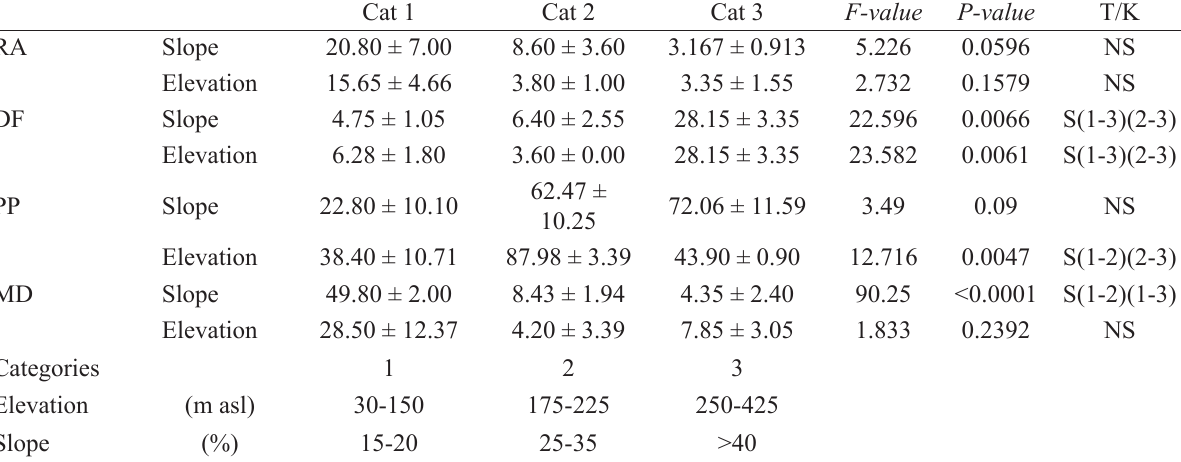
Table 3. ANOVA analysis of patch surface (percentage of DF surface at plot, plots mean ± SE) in various vegetation units taking plot’s elevation (m asl) and slope (%) as factors: Rural areas (RA), Meadows (MD), Degraded Forest (DF) and Conifer Plantations (PP). F-value, P-value and Tukey/Kramer (T/K) significance are given (NS= not